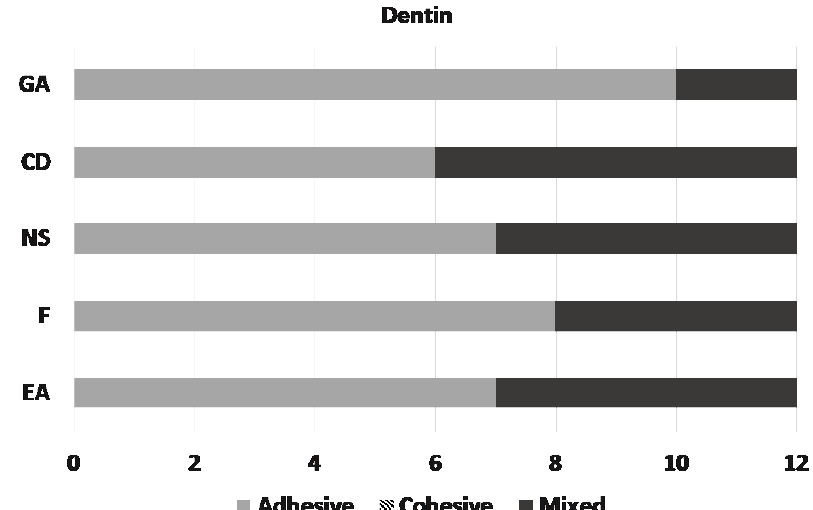
Figure 3. Distribution of the failure types on dentin.